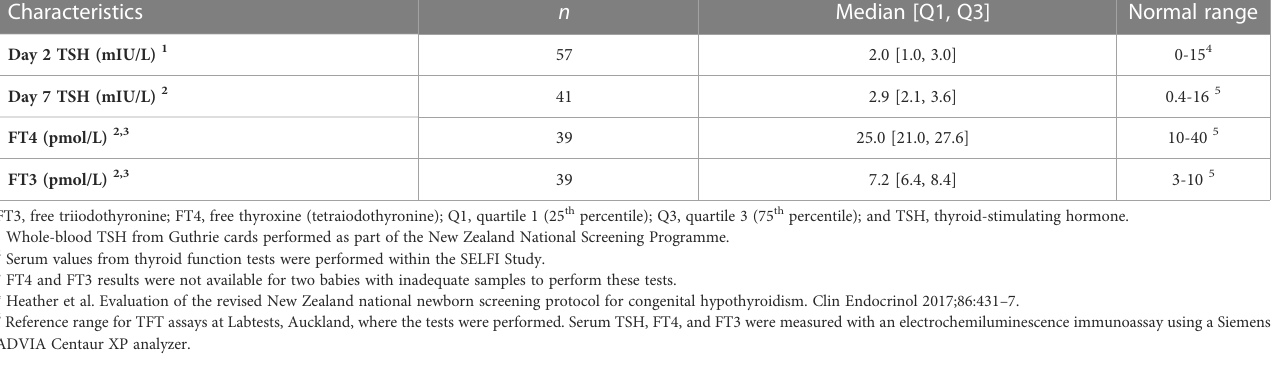
TABLE 2 Results of thyroid function tests in the SELFI Study offspring. Characteristics n